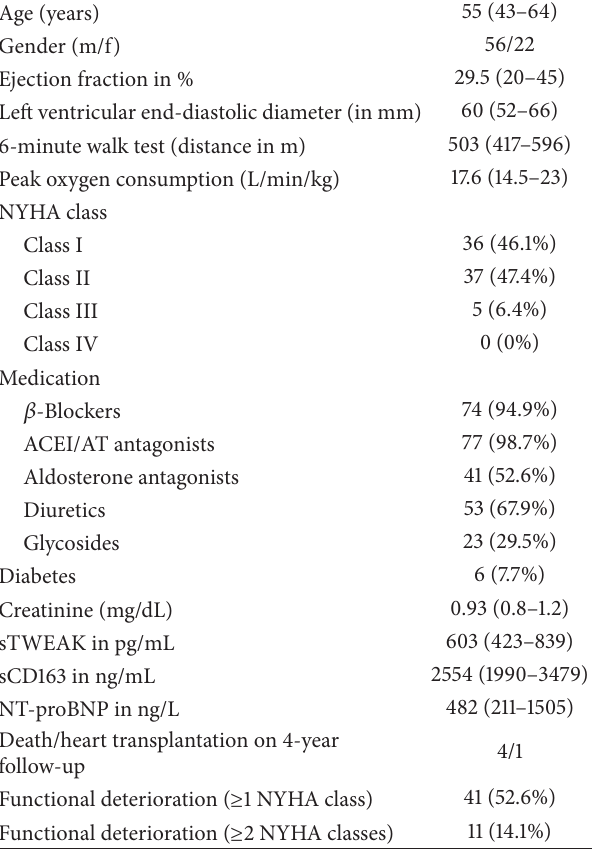
Table 1: Characteristics of the study cohort with dilated cardiomy- opathy ( 𝑛 = 78